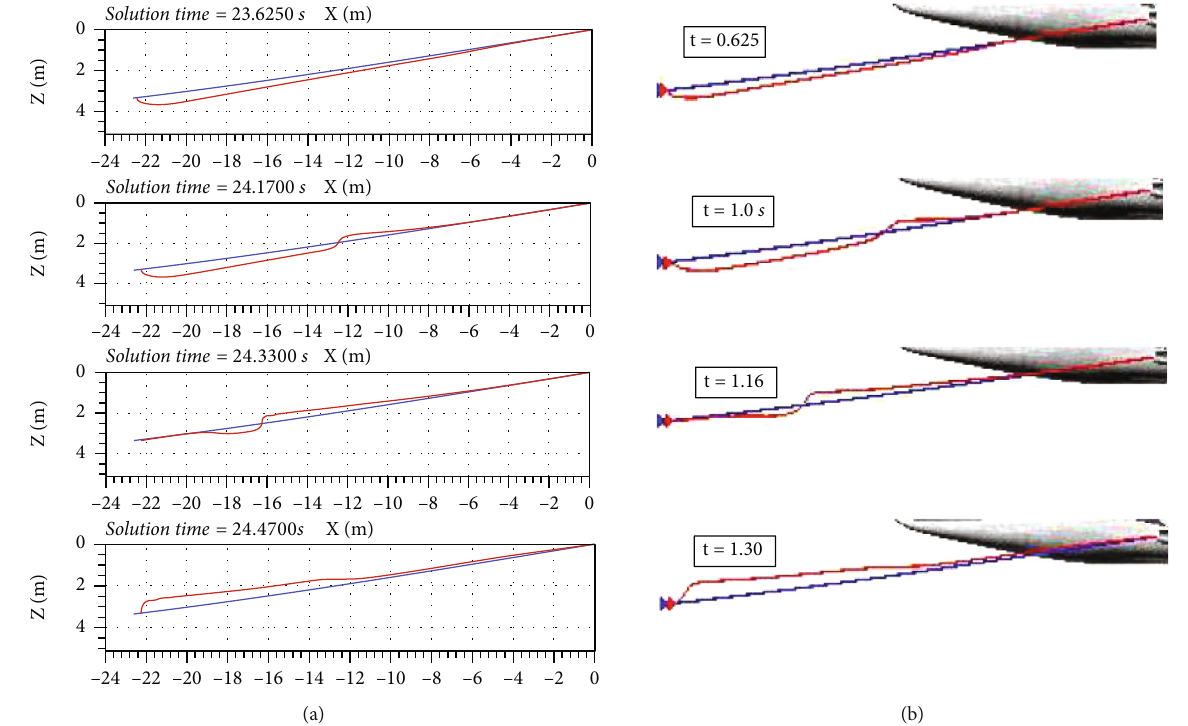
Figure 6: Hose geometry snapshot comparisons of the W1E0 (a) with the Ref. 20